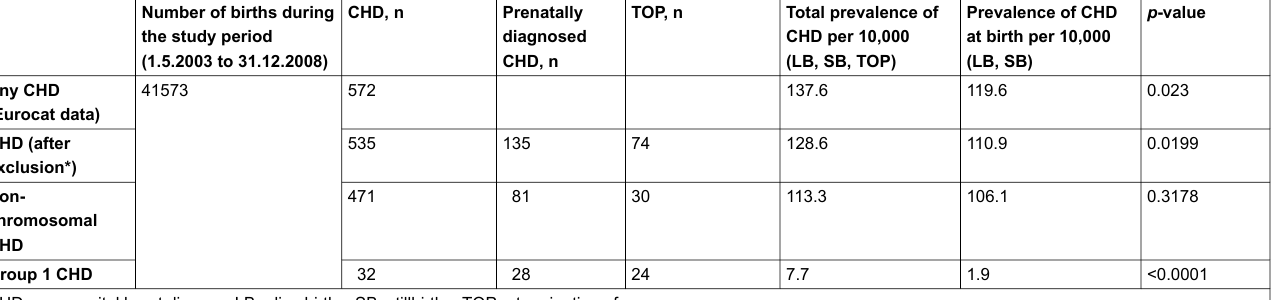
Table 2: Numbers of births, CHD cases, prenatally diagnosed CHD cases, and TOP decisions; total prevalence rates; and prevalence rates at birth for CHD (any CHD, CHD after exclusion, non-chromosomal CHD, and group 1 CHD), as well as a comparison of total CHD and CHD prevalence rates at birth in the Canton of Vaud, Switzerland (1.5.2003 to